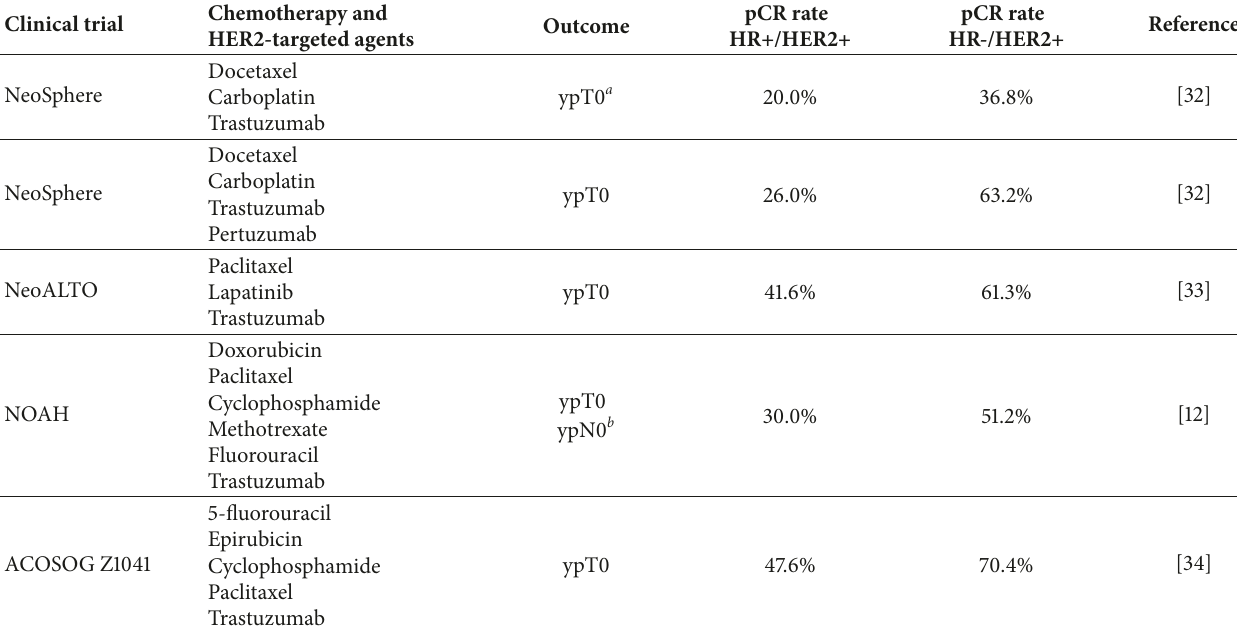
Table 1: Pathologic complete response after neoadjuvant chemotherapy in patients with HER2-positive breast cancer stratified by hormonal receptor